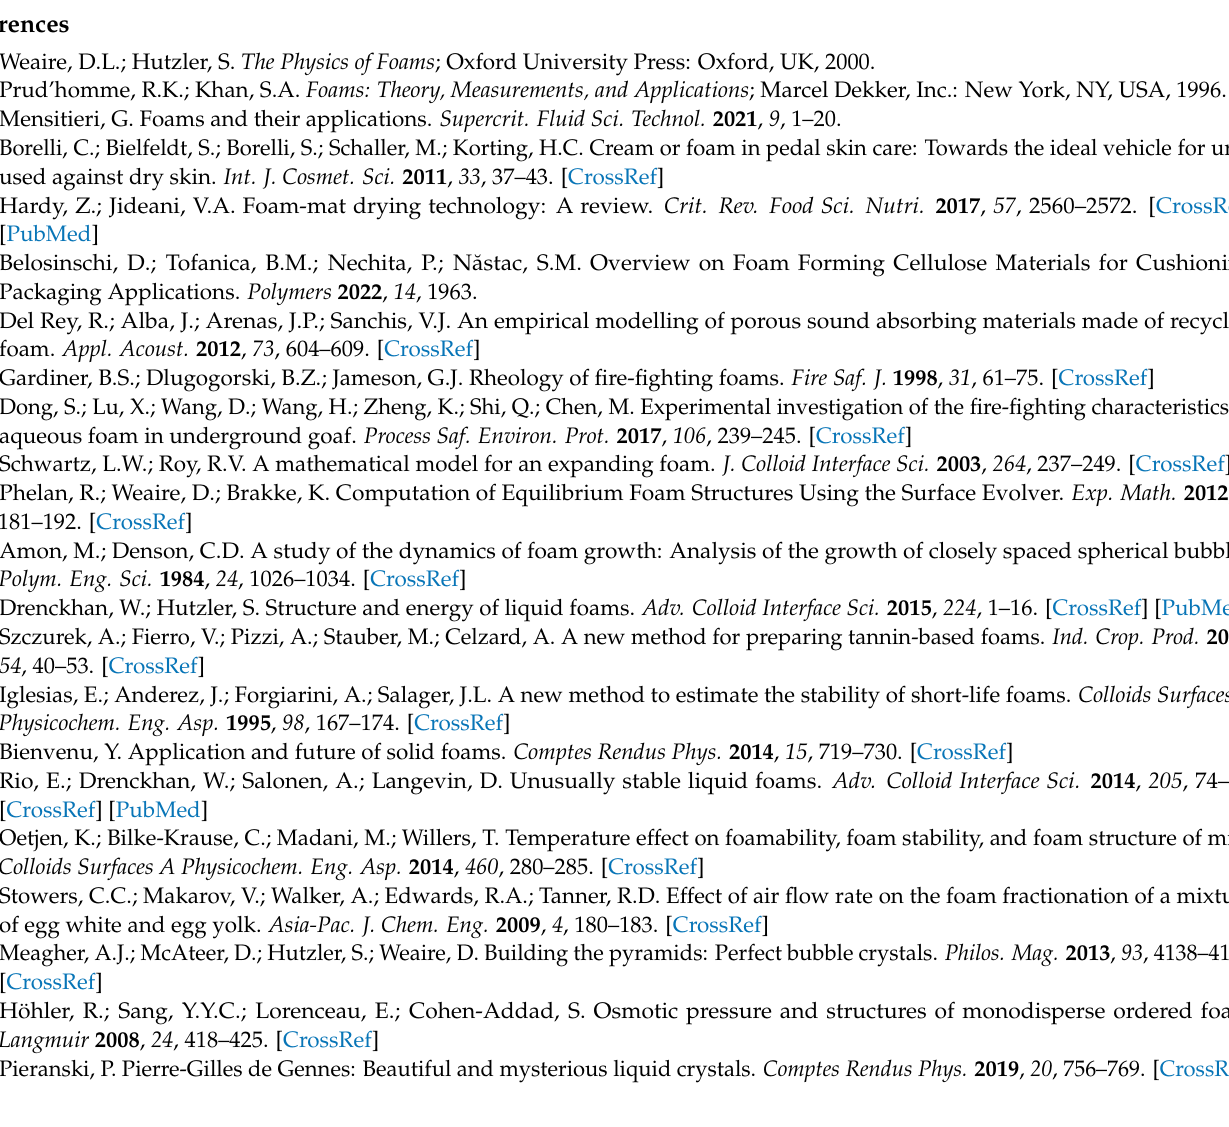
containers. Figure S2: SDS foam confined in square containers. Figure S3: SDS foam confined in cylindrical containers. Figure S4: Drainage effect on the SDS and LC